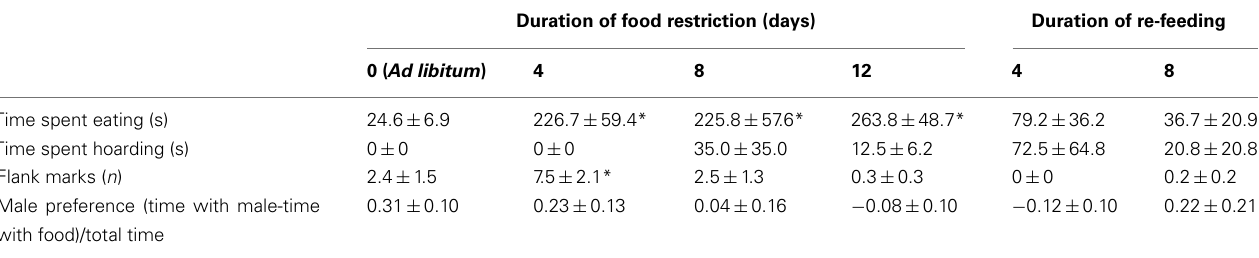
Table 1 | Mean and SEM for appetitive behaviors (other than those shown in Figure 1) measured at different durations of 75% food restriction in female Syrian hamsters provided with a choice between food and a male hamster.